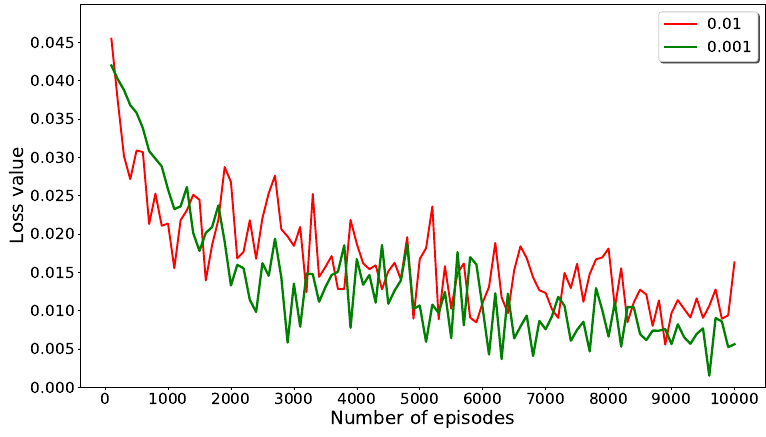
Figure 11. Loss value under different learning